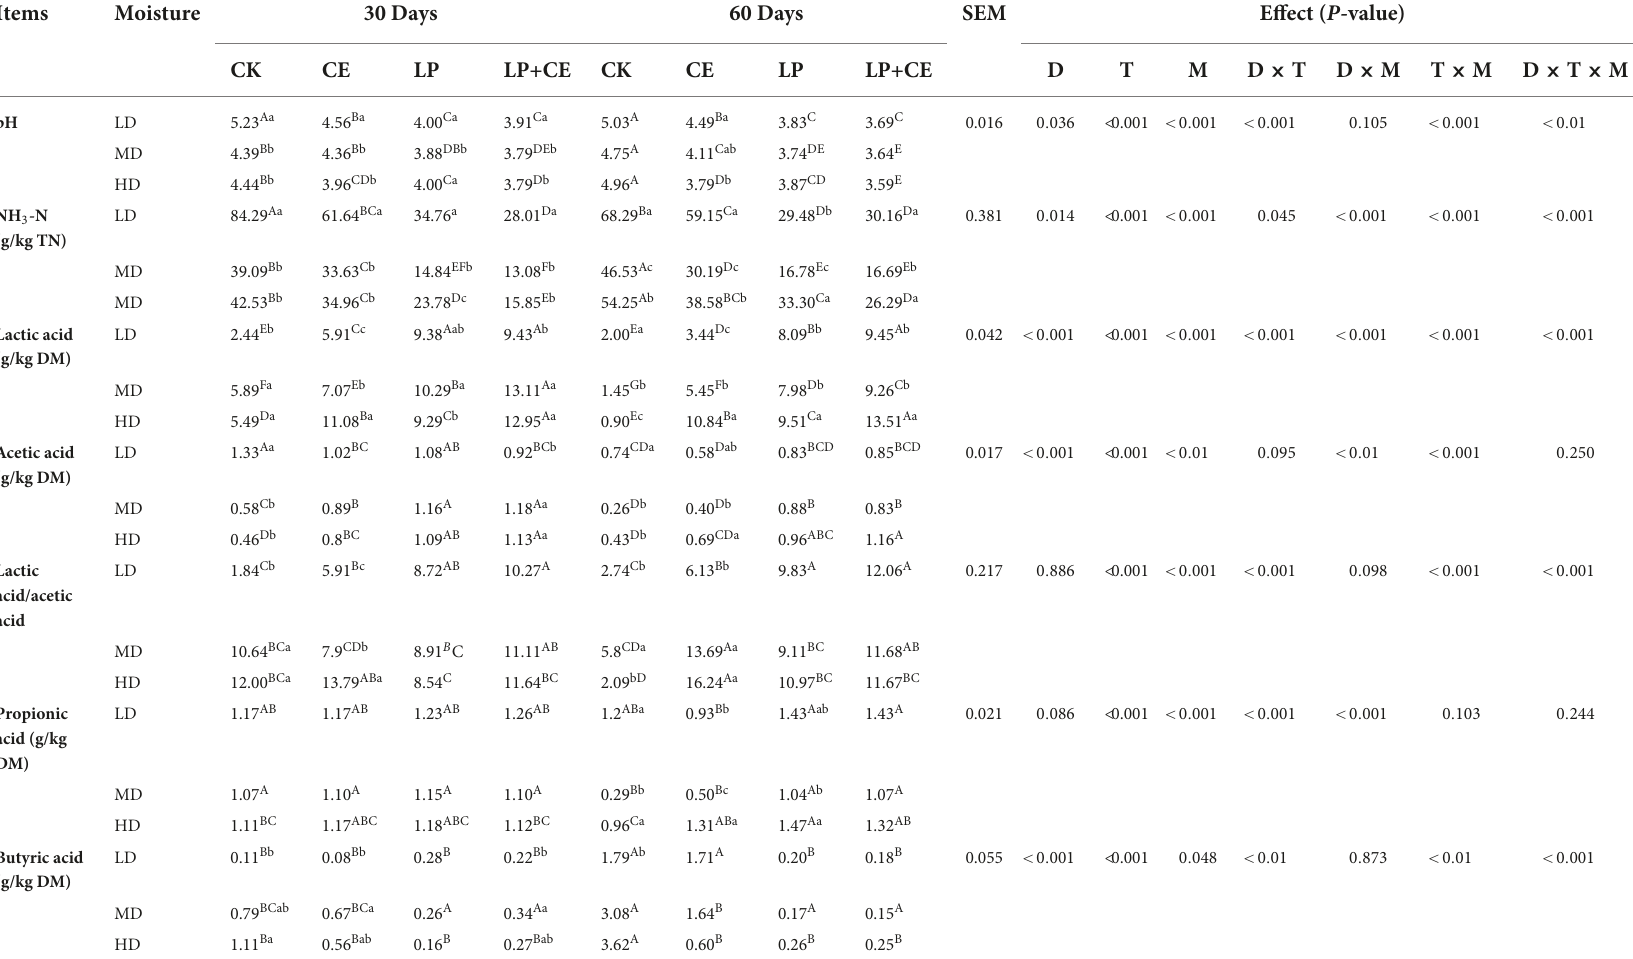
TABLE 2 The fermentation characteristics of oat silage at 30 and 60 days.